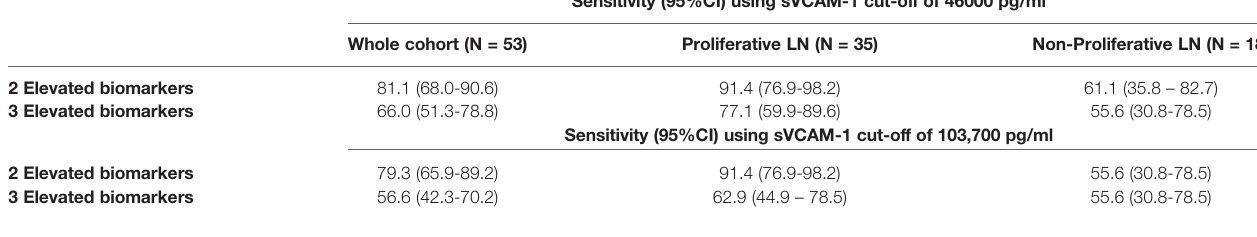
TABLE 5 | Sensitivity of our “ rule in ALN ” criteria in a biopsy-proven ALN cohort.